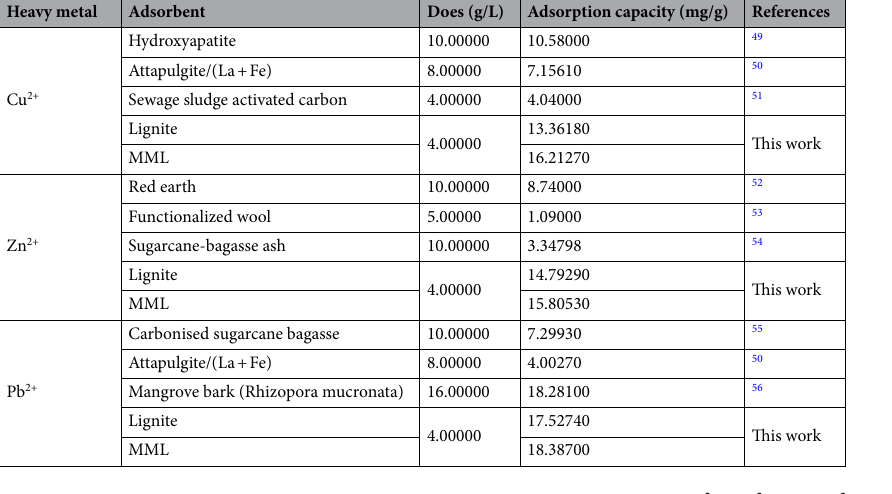
Table 4. Comparison of the maximum monolayer adsorption capacities of Cu 2+ , Zn 2+ and Pb 2+ on various